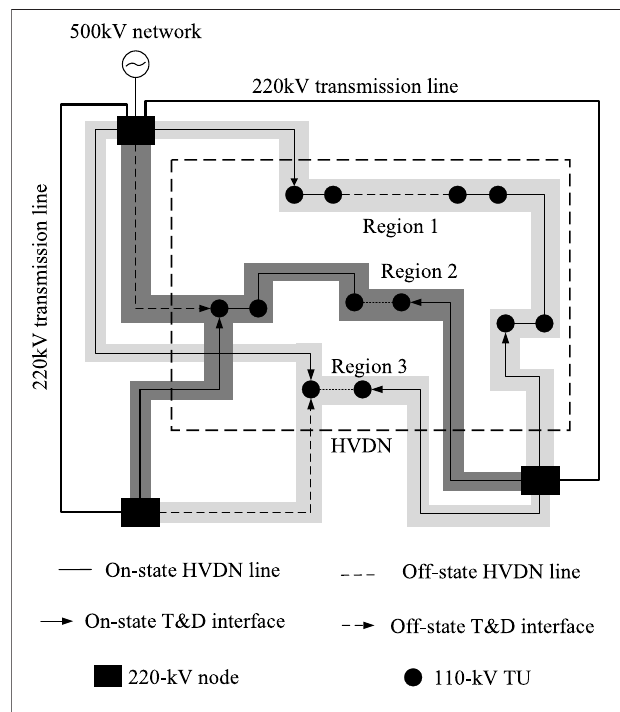
FIGURE 3 | Simpli fi ed urban power grid